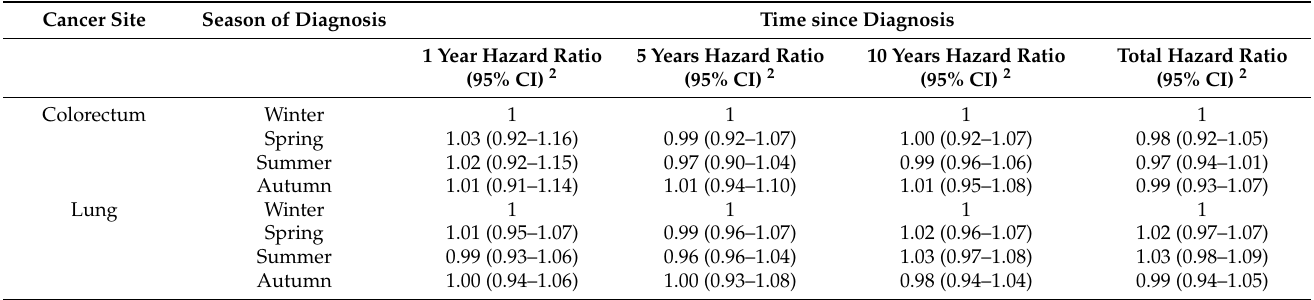
Table 3. Mortality Hazard Ratios by season of diagnosis and time since diagnosis in